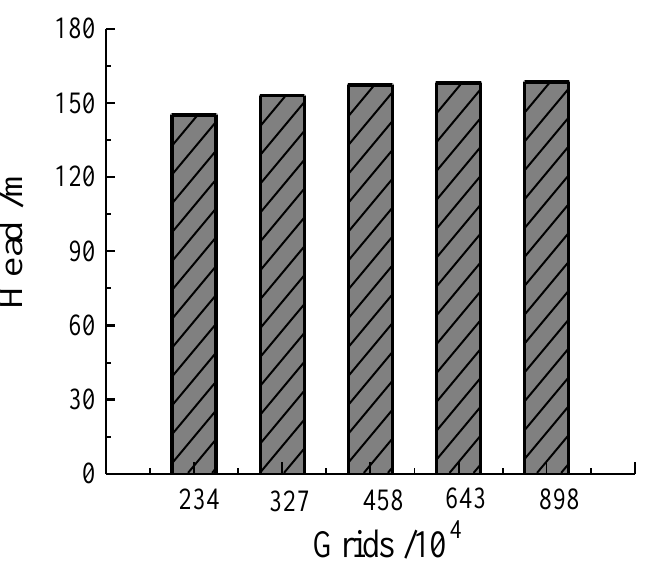
Figure 4. Grid independence analysis.